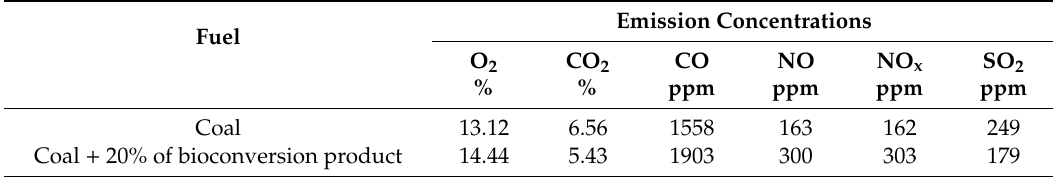
Table 3. Average values of the concentration of emissions during di ff erent fuel